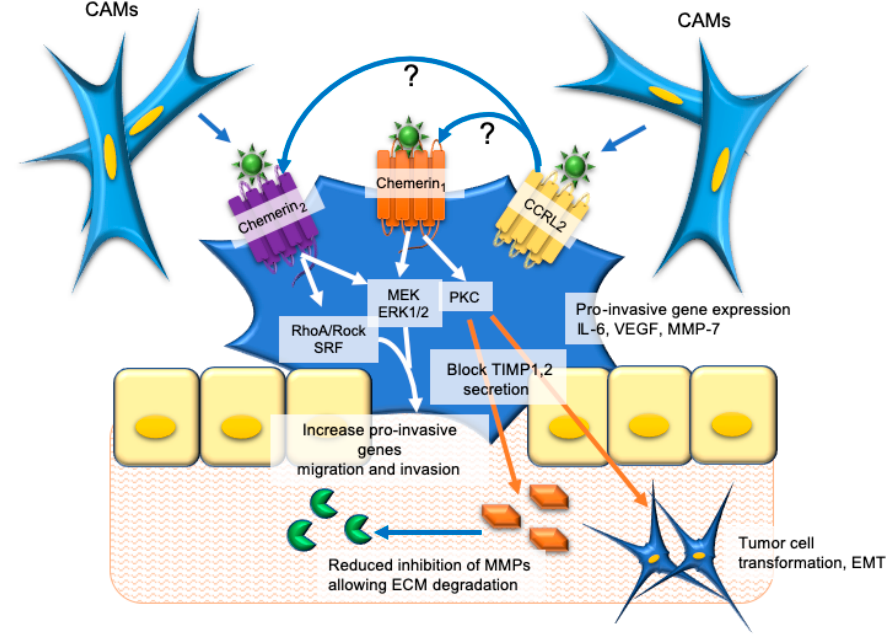
Figure 2. The mechanisms of tumor-promoting effects of chemerin in the gastric carcinoma microenvironment. Chemerin is released from cancer-associated myofibroblasts (CAMs) and acts